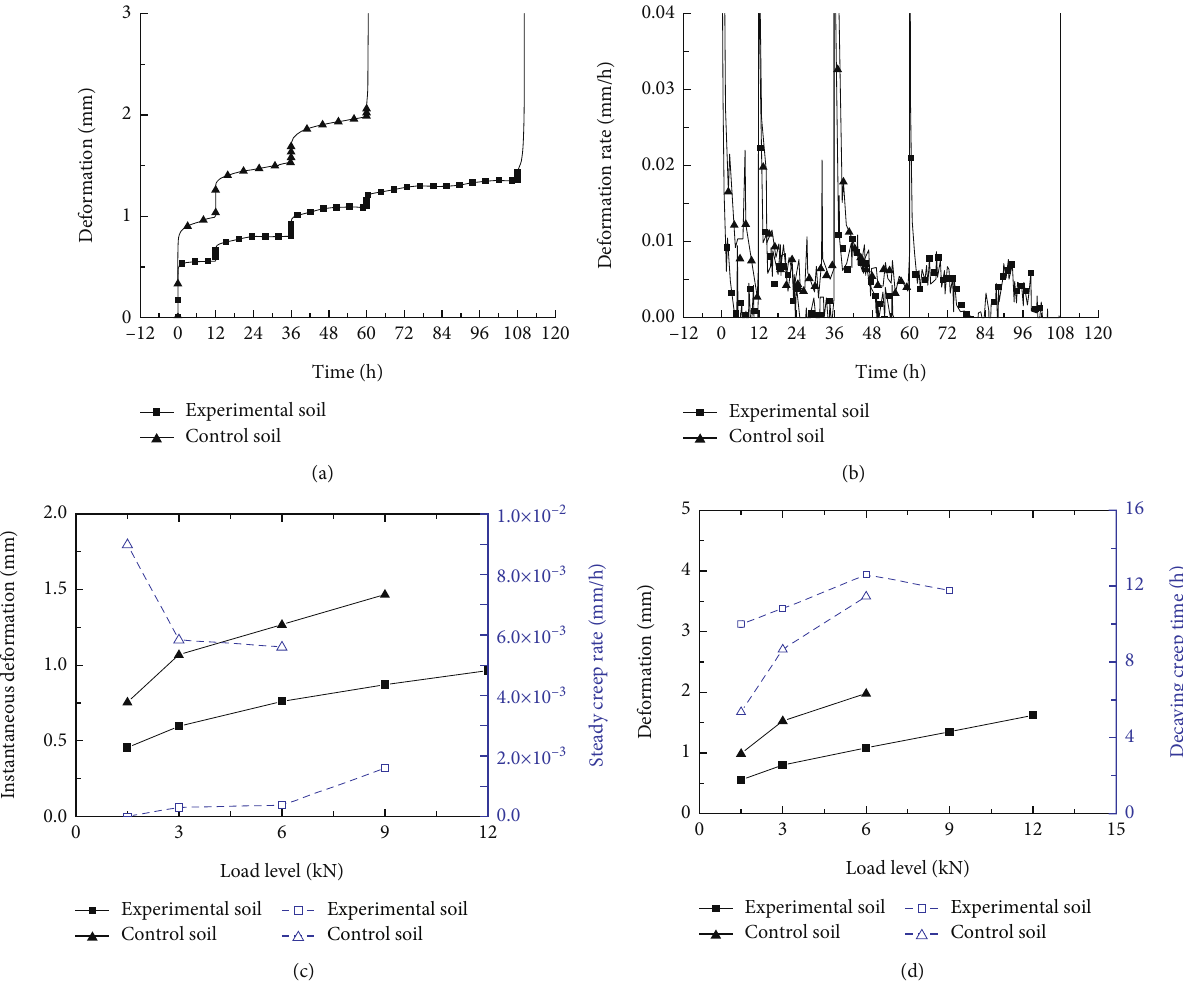
Figure 11: Creep parameters of interfaces between pile and frozen soil with di ff erent grain